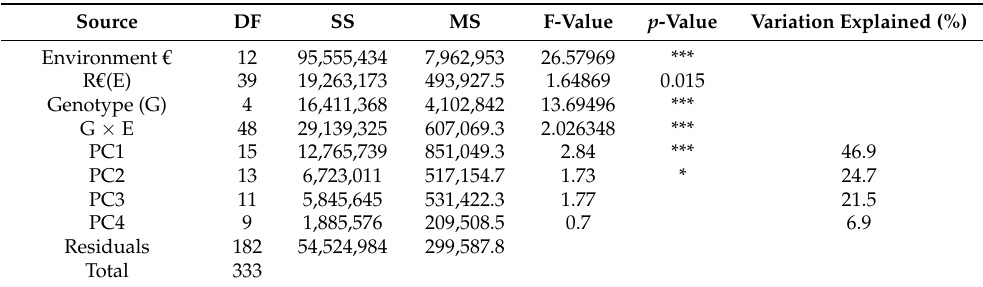
Figure 7. Plot of the performance of five cultivars on estimated environmental value. Each color represents a different cultivar. Lines are fitted values of genotype by environment combination. The horizontal axis displays the estimated environmental effects and the vertical axis represents the yield performance. Table 6. Analysis of variance of additive main effects and multiplicative interaction (AMMI) for yield on the genotype and environment